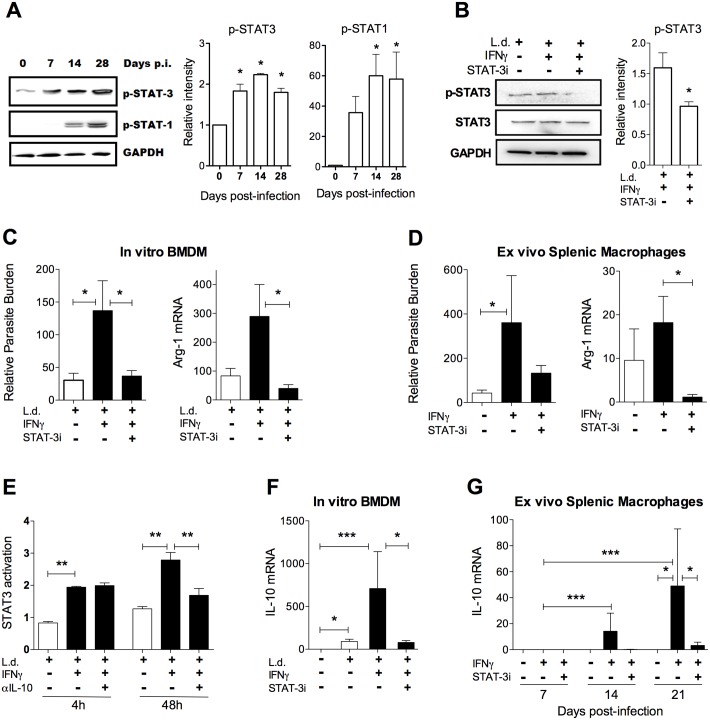
IFN-γ-mediated counter-regulatory response and increased parasite load in macrophages is dependent on STAT3 activation.(A) Representative immunoblots showing phosphorylation of STAT1 and STAT3 in splenic macrophages from uninfected (day 0) and L. donovani infected (day 7, 14 and 28) hamsters. The relative band intensities are graphed from data from 3 experiments with samples pooled from 4 hamsters per time point. (B) Representative immunoblot of phospho-STAT3 (p-STAT3) expression in infected splenic macrophages after 20 min of IFN-γ exposure with and without treatment with 100 μM STAT3 inhibitor (STAT-3i) before IFN-γ stimulation. The relative intensities of the p-STAT3 bands are graphed, representative of 3 experiments. (C) Relative parasite burden (left panel) and arginase-1 (Arg-1) expression (right panel) in hamster BMDM infected in vitro with L. donovani and treated or not for 24 hrs with IFN-γ, with or without pre-treatment with the STAT3 inhibitor (STAT-3i). Fold change compared to mock treated macrophages. (D) Relative parasite burden (left panel) and arginase-1 (Arg-1) expression (right panel) in splenic macrophages from L. donovani infected hamsters (21 days p.i.), cultured and stimulated ex vivo for 24h with or without IFN-γ, with or without pre-treatment with the STAT3 inhibitor (STAT3i). Fold change compared to mock treated macrophages. (E) STAT3 Luciferase reporter assay in BHK cells transduced with STAT3 lentiviral reporter (Cignal Lenti, Qiagen) exposed or not for 4h or 48h to L. donovani with or without IFN-γ, with or without or pre-treatment with 2 μg/mL of anti-mouse/rat IL-10 neutralizing antibody (AF519, R&D). (F) Interleukin-10 (IL-10) mRNA expression in hamster BMDM uninfected or infected in vitro with L. donovani and stimulated or not for 24 hours with IFN-γ, with or without pre-treatment with the STAT3i. Fold change compared to mock treated macrophages. (G) Interleukin-10 (IL-10) expression in splenic macrophages from hamsters isolated 7, 14, or 21 days after infection with L. donovani, and cultured and stimulated ex vivo with IFN-γ for 24h, with or without pre-treatment with the STAT3 inhibitor (STAT3i). Fold change compared to mock treated macrophages. *p<0.05, **p<0.01, ***p<0.001.